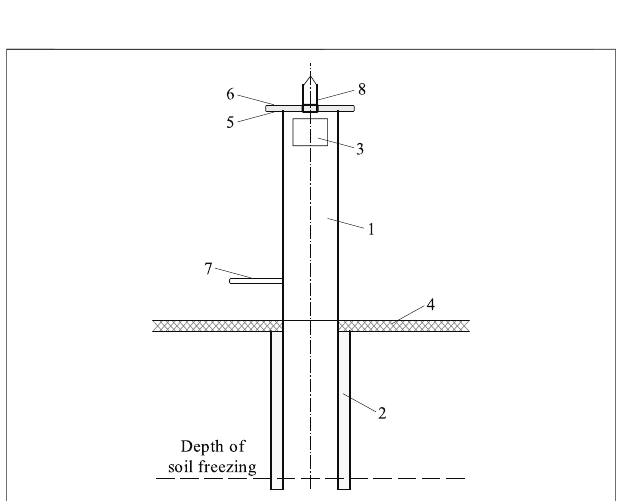
FIGURE 9 | Ground-based FCS construction: 1, metal pipe; 2, concreted lower part; 3, window for setting the device; 4 is earth surface; 5, fi rst metal platform; 6, station center; 7, second metal platform; 8, sighting